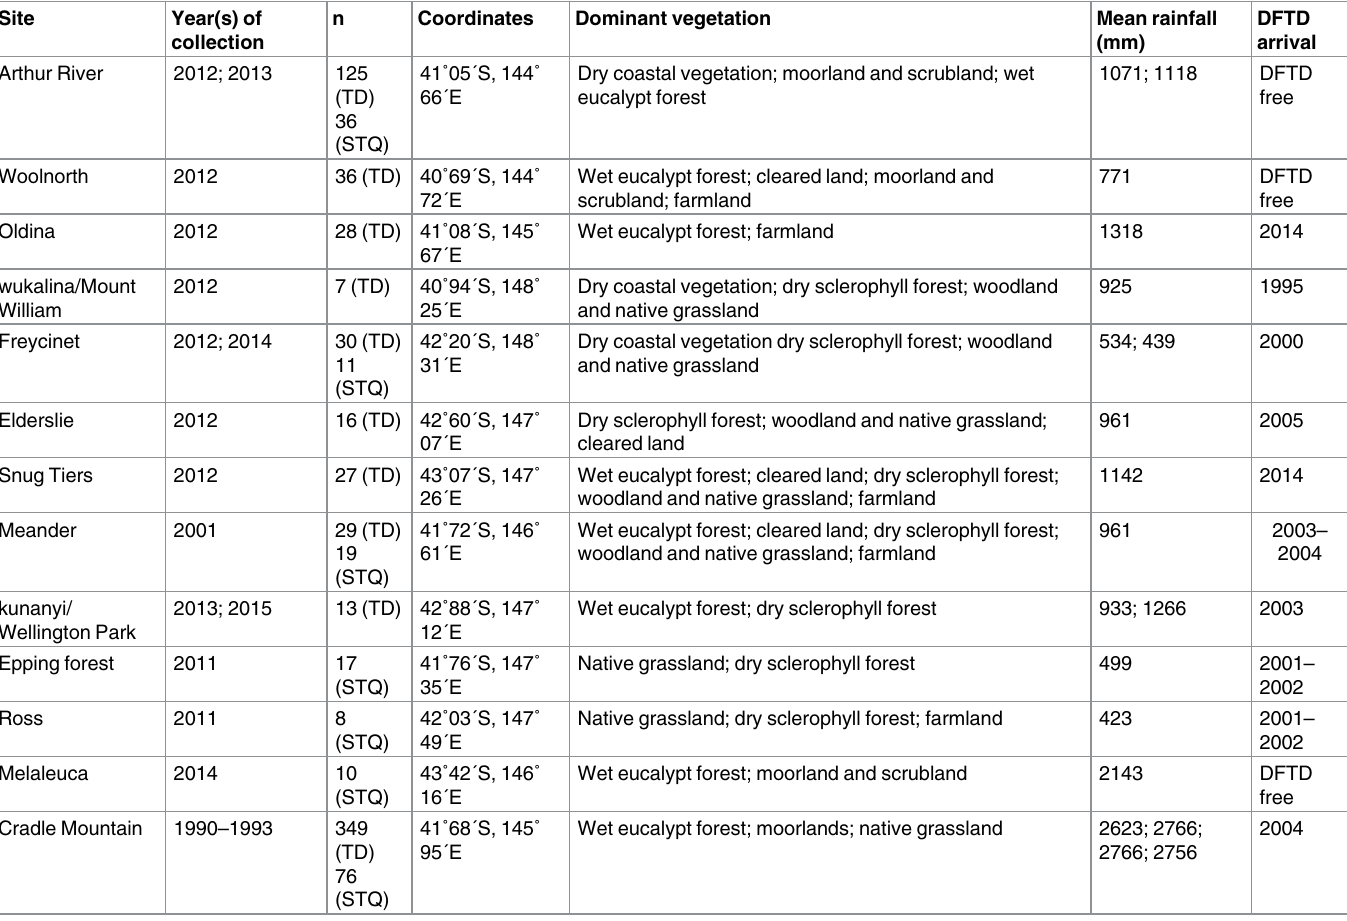
Table 1. Details of the site, year(s) of scat collection, location, dominant vegetation types, mean rainfall (mm) over the five years preceding the period of scat collection and year of devil facial tumour disease outbreak (DFTD) for each of the thirteen sites, where scats were collected. n = number of devil (TD) and quoll (STQ) scats